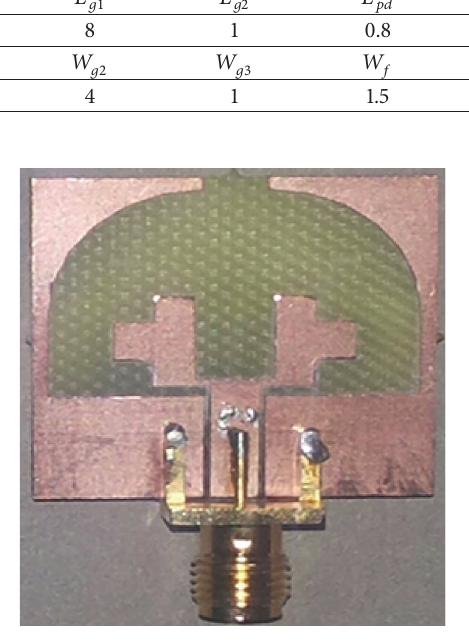
Figure 2: Photograph of the fabricated CPW-fed two-sided T strip wideband microstrip antenna.